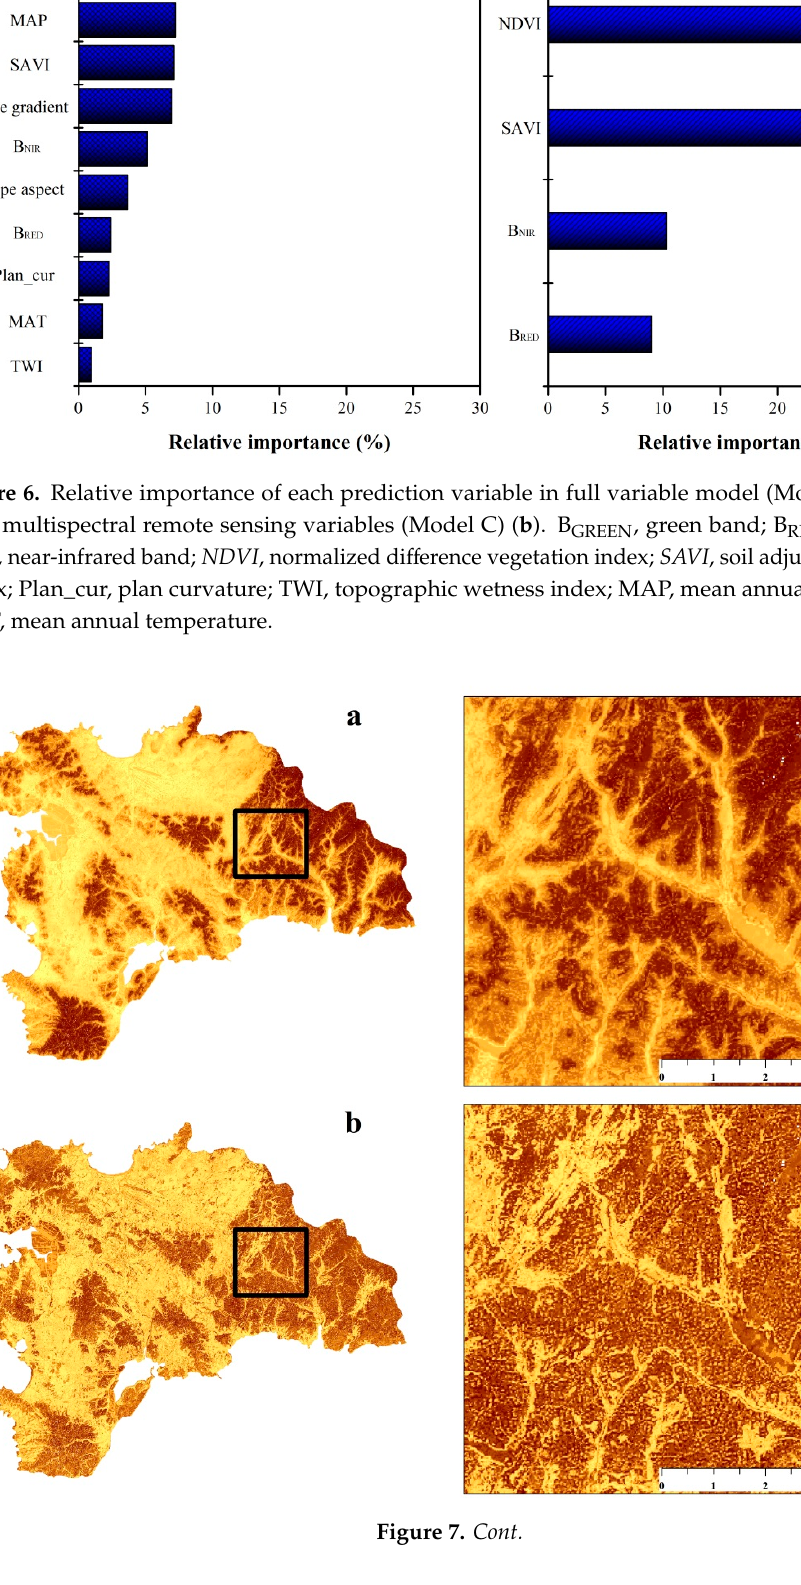
Figure 7. Distribution maps of topsoil (0–30cm) organic carbon stocks (kg m − 2 ) derived from three boosted regression tree (BRT) models. ( a ) full variables model (Model A); ( b ) topography and climate variables (Model B); and ( c ) only multispectral remote sensing variables (Model C); ( d – f ) areas covered with black boxes are detailed on the right. Terrain related variables are good predictors of SOC stocks in complex terrain change areas [8,17]. As one of the five soil-forming factors [40], topographic variables as a common variable in digital soil mapping (DSM) were selected as the main prediction factor in this study. In the process of SOC stocks prediction, the relative importance of terrain related variable was lower than that of multi spectral remote sensing related variable, which was consistent with previous research results [7,8,17,34]. Yang et al. [17] considered that, in the area with abundant vegetation, the influence of